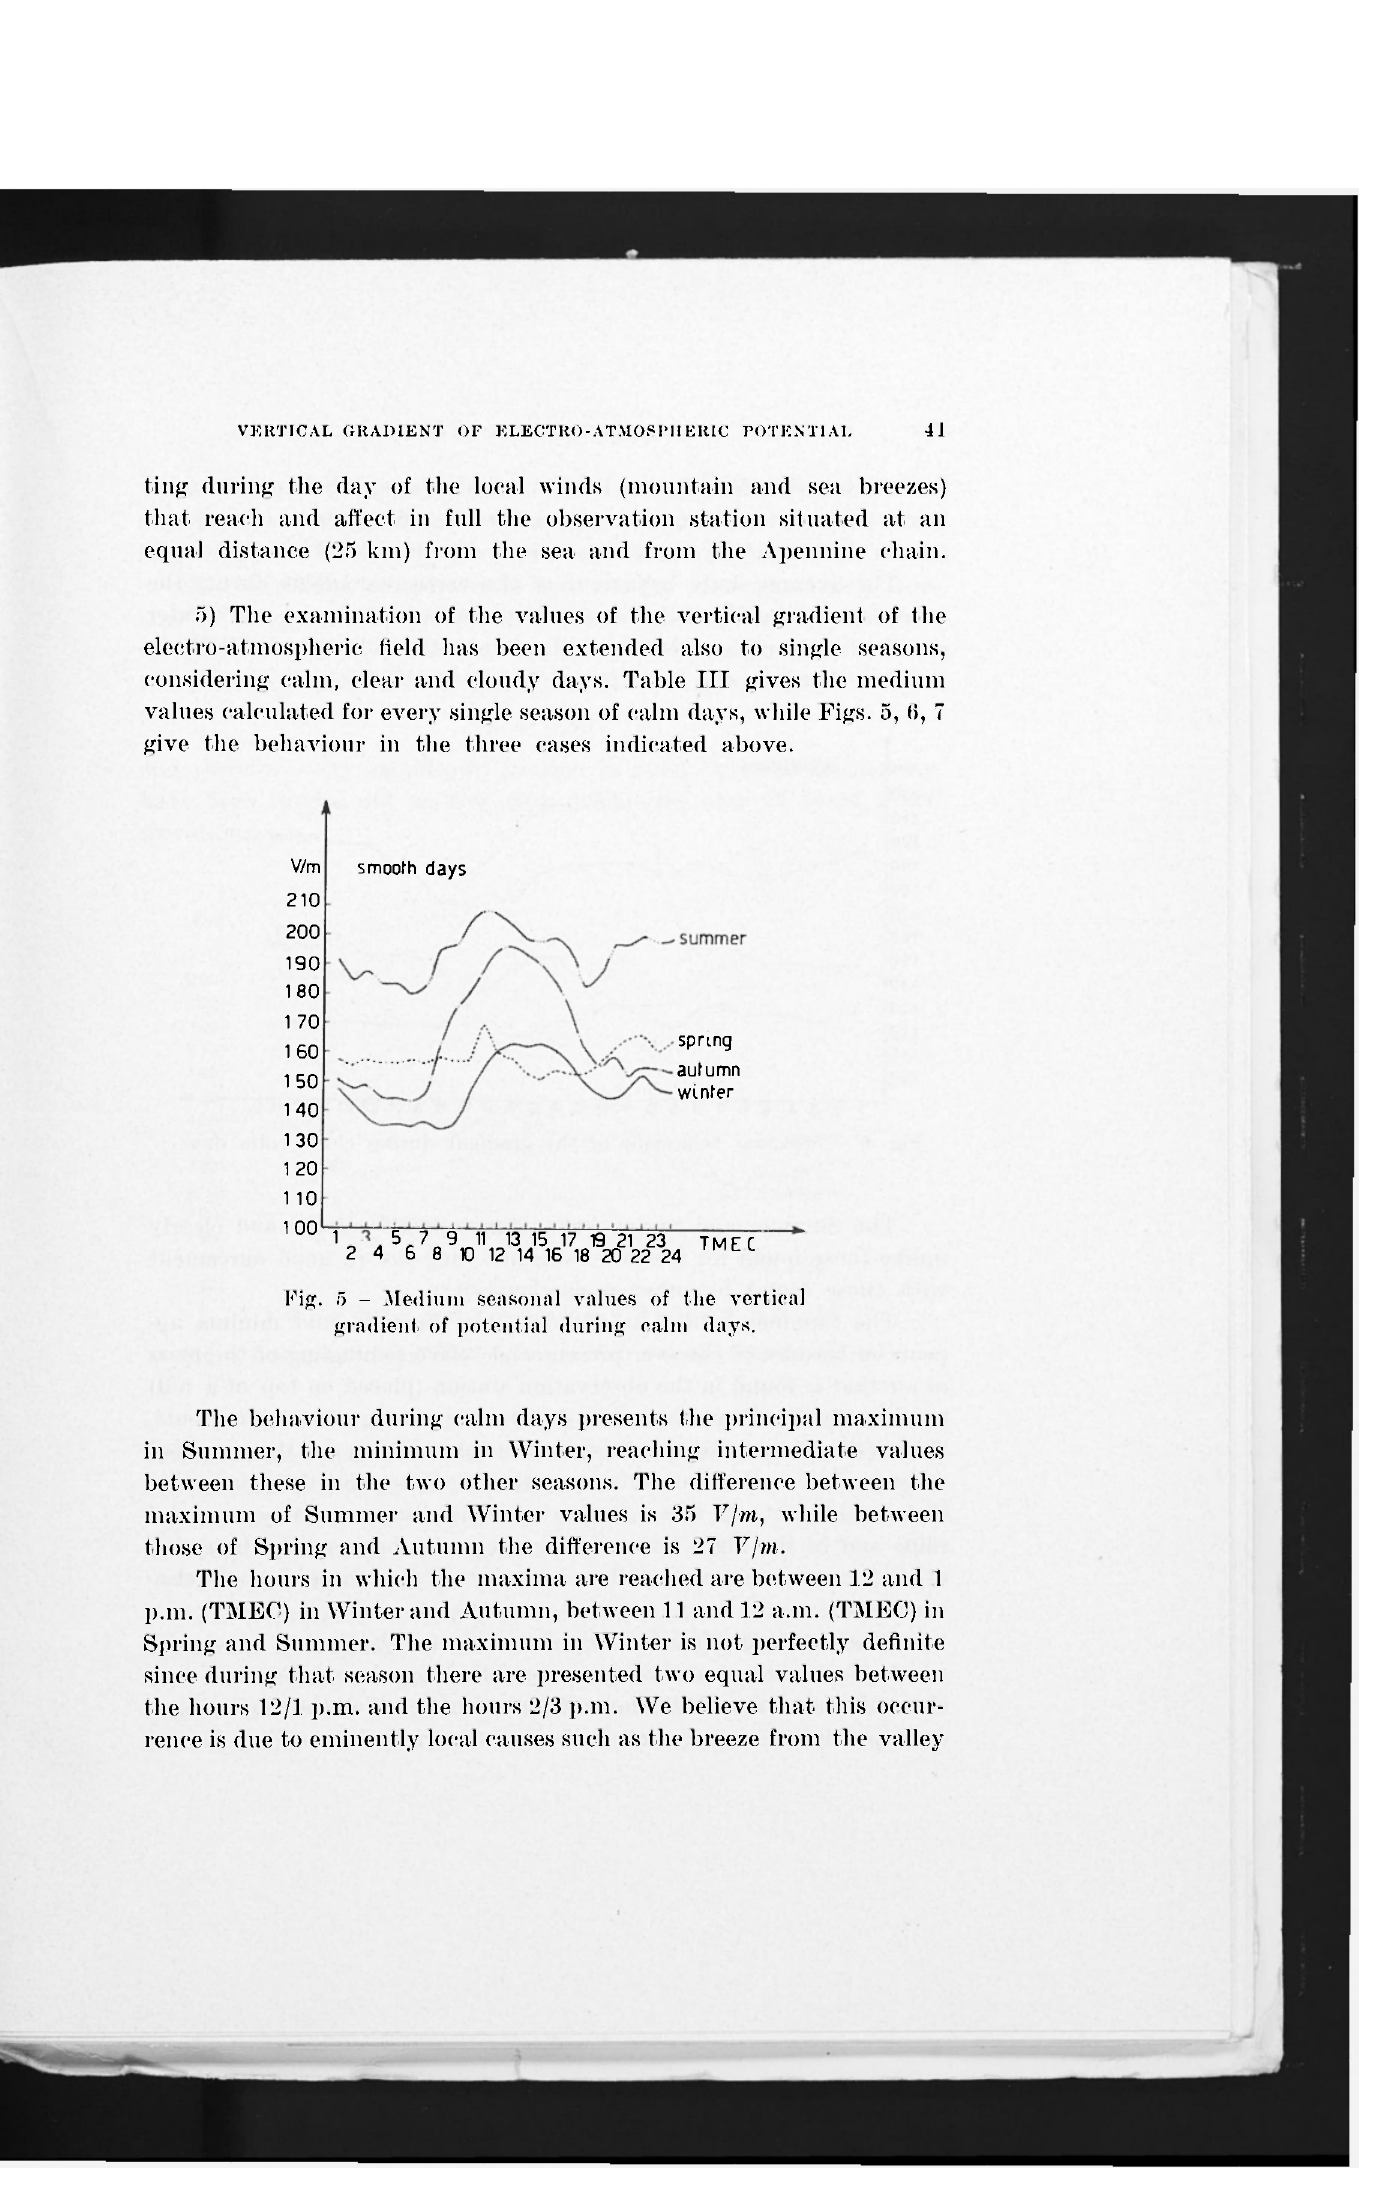
Pig. 5 - Medium seasonal values of the vertical gradient of potential during calm